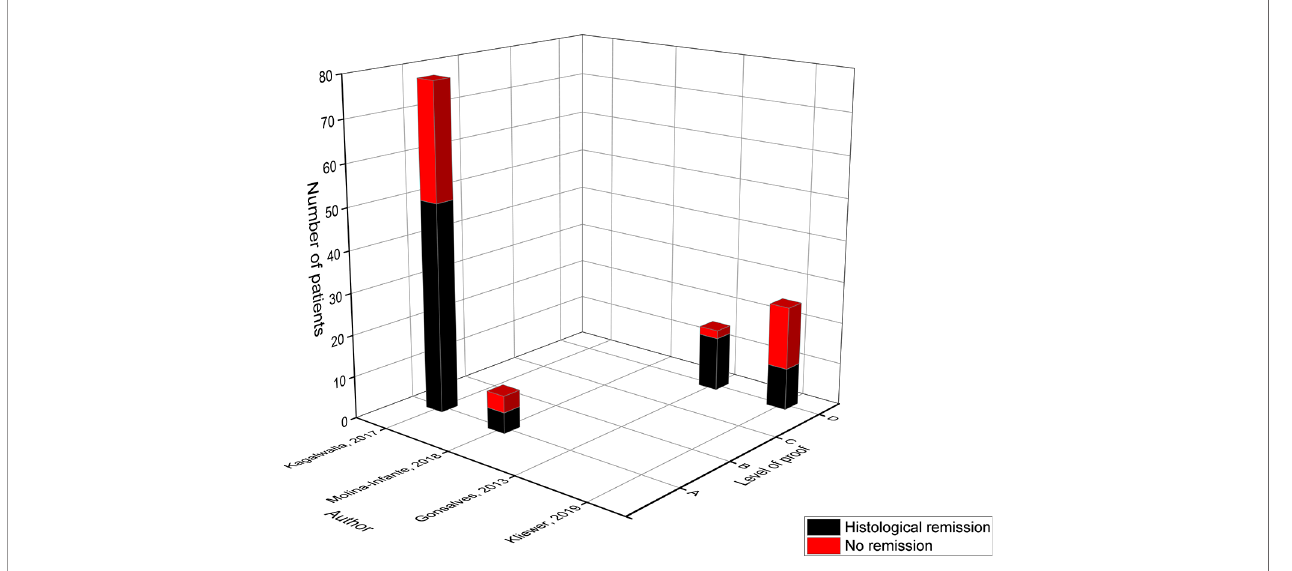
FIGURE 5 | Level of proof of studies on the 4-food elimination